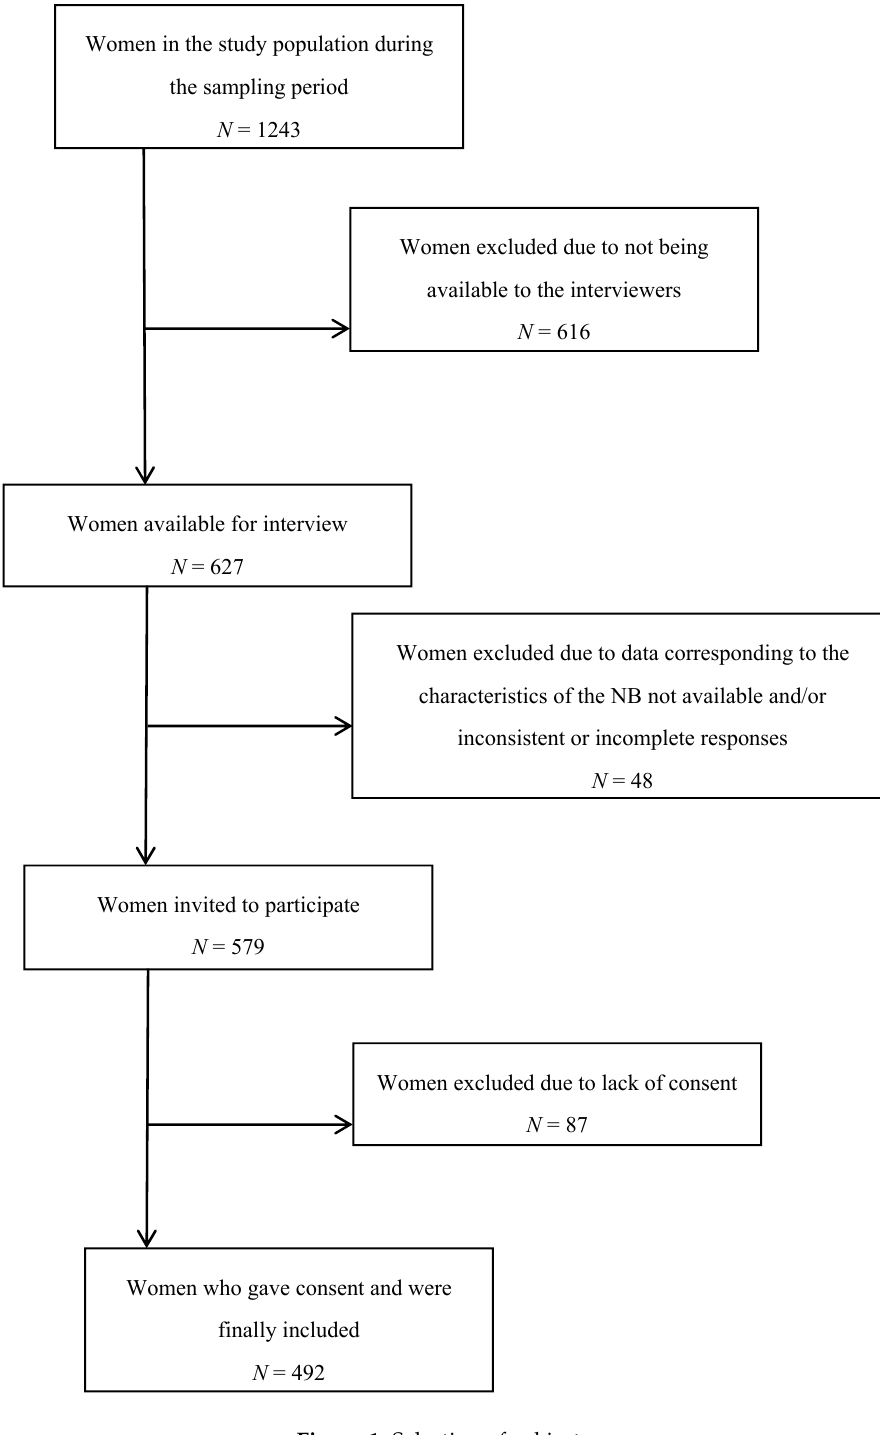
Figure 1. Selection of subjects.